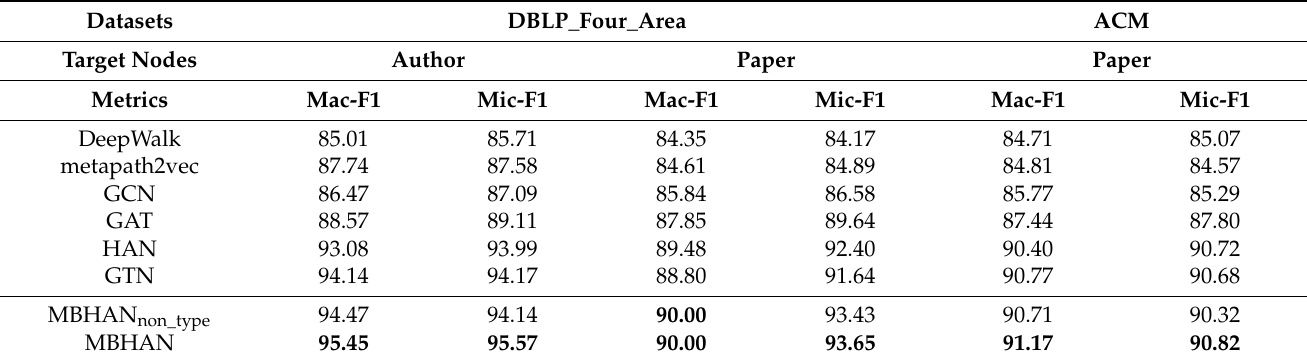
Table 3. Node classification performance results